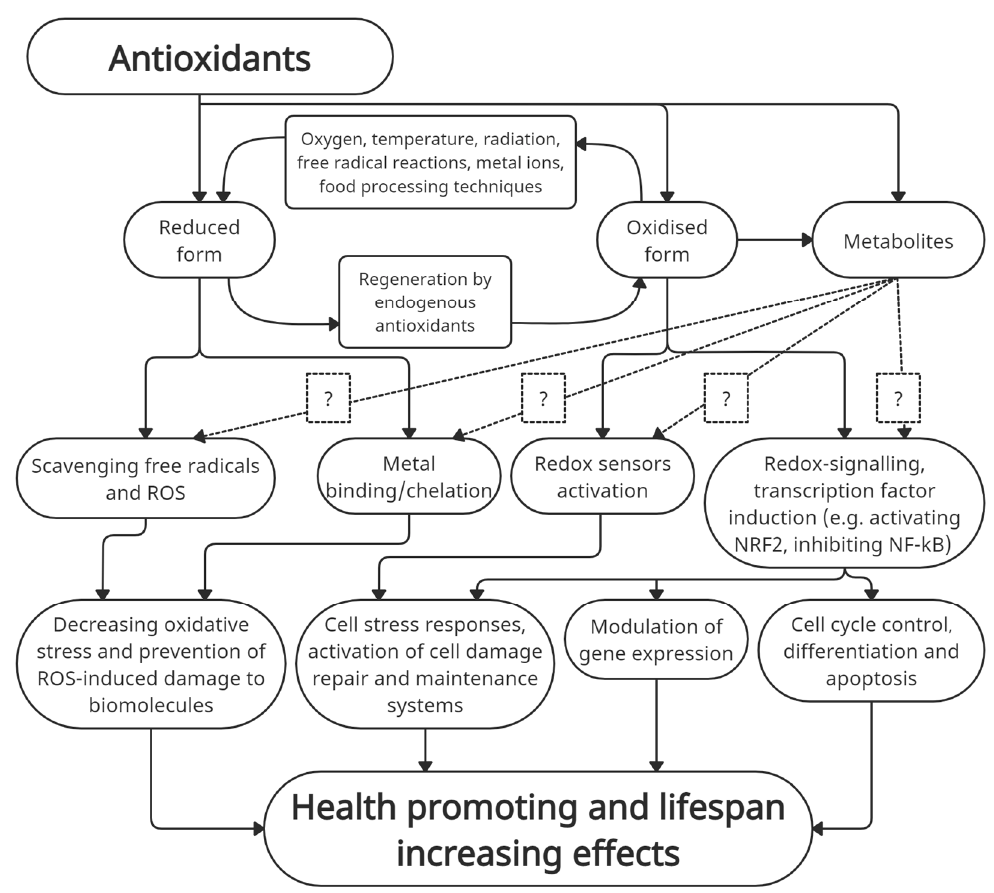
Figure 1. The health-promoting roles of antioxidants and their metabolites.